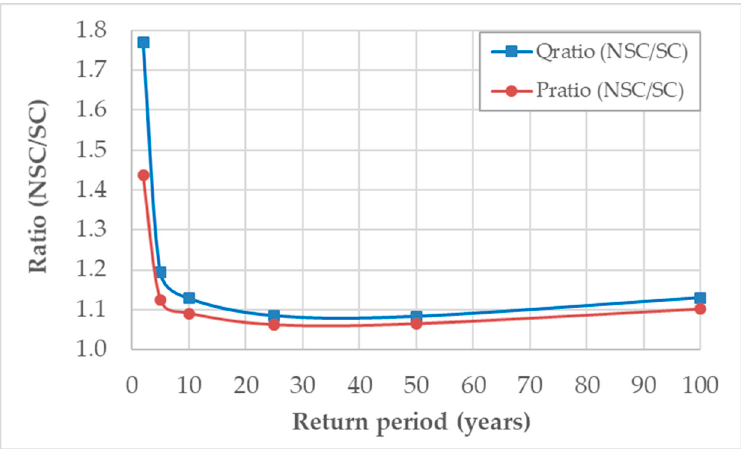
Figure 11. P 24h-max and peak flow variation for various return periods. DPmax and DQp are the P 24h-max and peak flow difference between non-stationary and stationary conditions. Fluids 2018 , 3 , x FOR PEER REVIEW